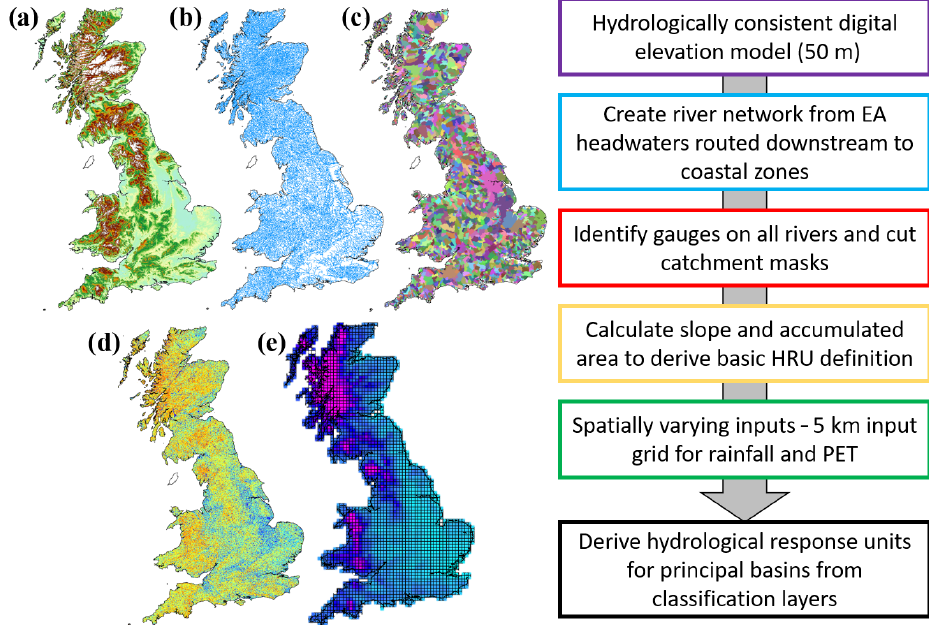
Figure 5. Inputs and outputs of digital terrain analyses for GB: (a) 50m hydrologically consistent digital elevation model, (b) DECIPHeR river network, (c) nested catchment mask, (d) topographic index and (e) 5km input